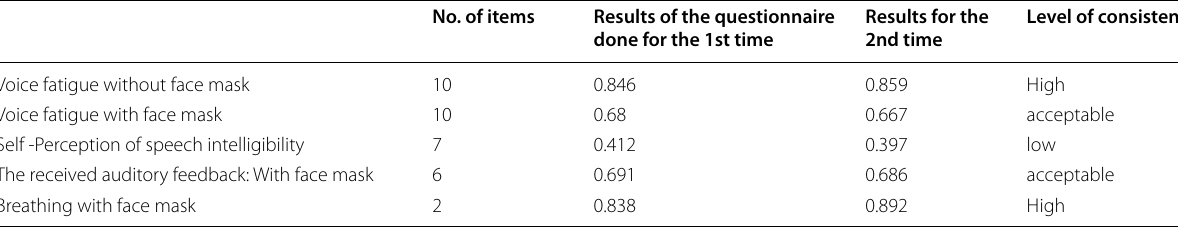
Table 13 Correlation test for test–retest reliability